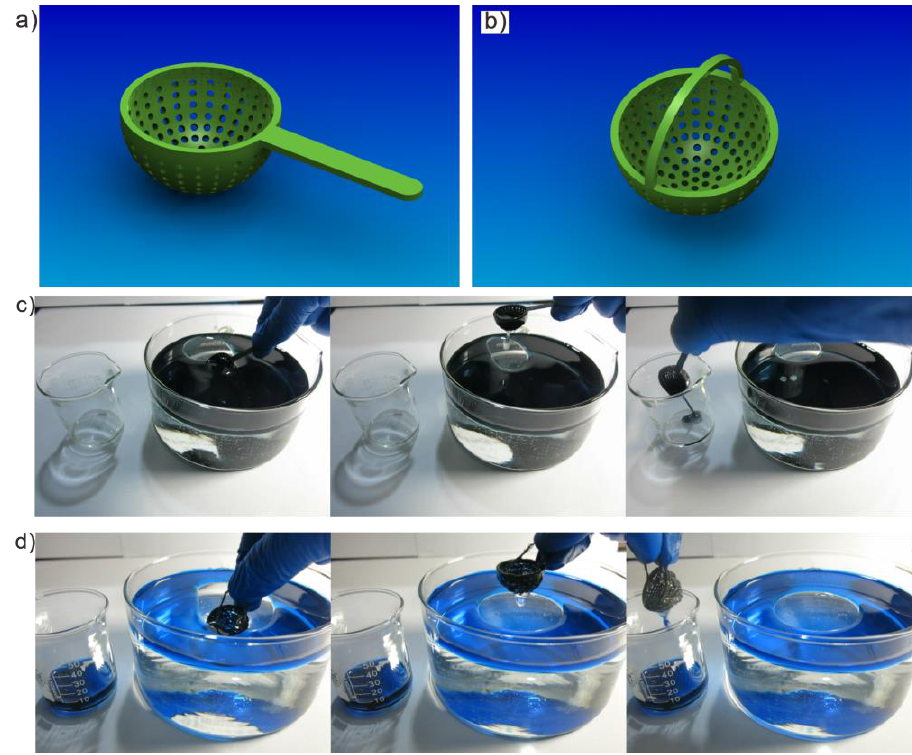
Figure 6. Floating oil removal by 3D-printed spherical oil skimmers. ( a ) The design of a spoon skimmer and ( b ) a barrel skimmer. Collecting floating oil of ( c ) dodecane dyed in blue on water by using spoon skimmer and ( d ) diesel dyed in green with barrel skimmer.